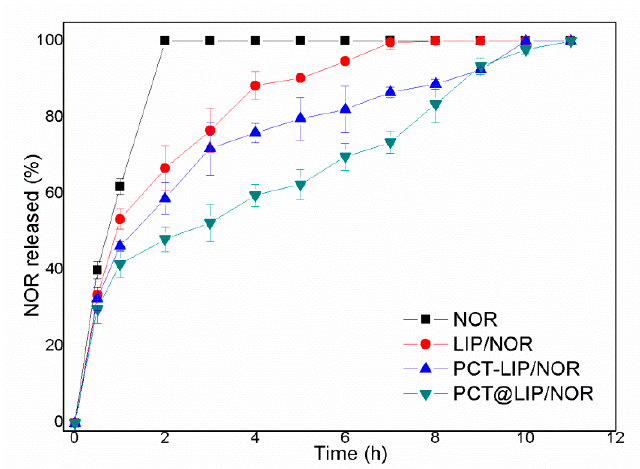
Figure 3. In vitro release profile of norfloxacin (0.2%), free or encapsulated in LIP / NOR, PCT-LIP / NOR, and PCT@LIP / NOR samples, at 37 ◦ C, n = 5. Table 1. Determination of the minimum inhibitory concentration (MIC, µ g / mL) for NOR (in